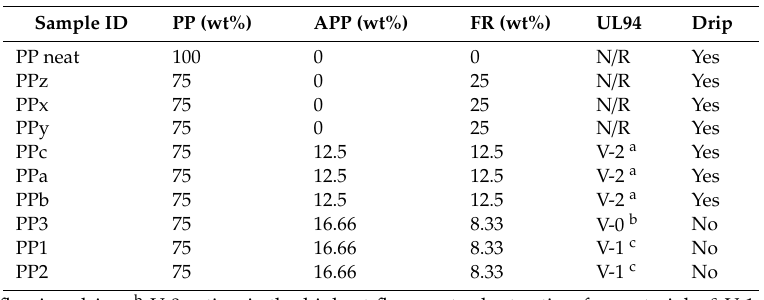
Table 3. Flammability test of the prepared polypropylene (PP) composite.